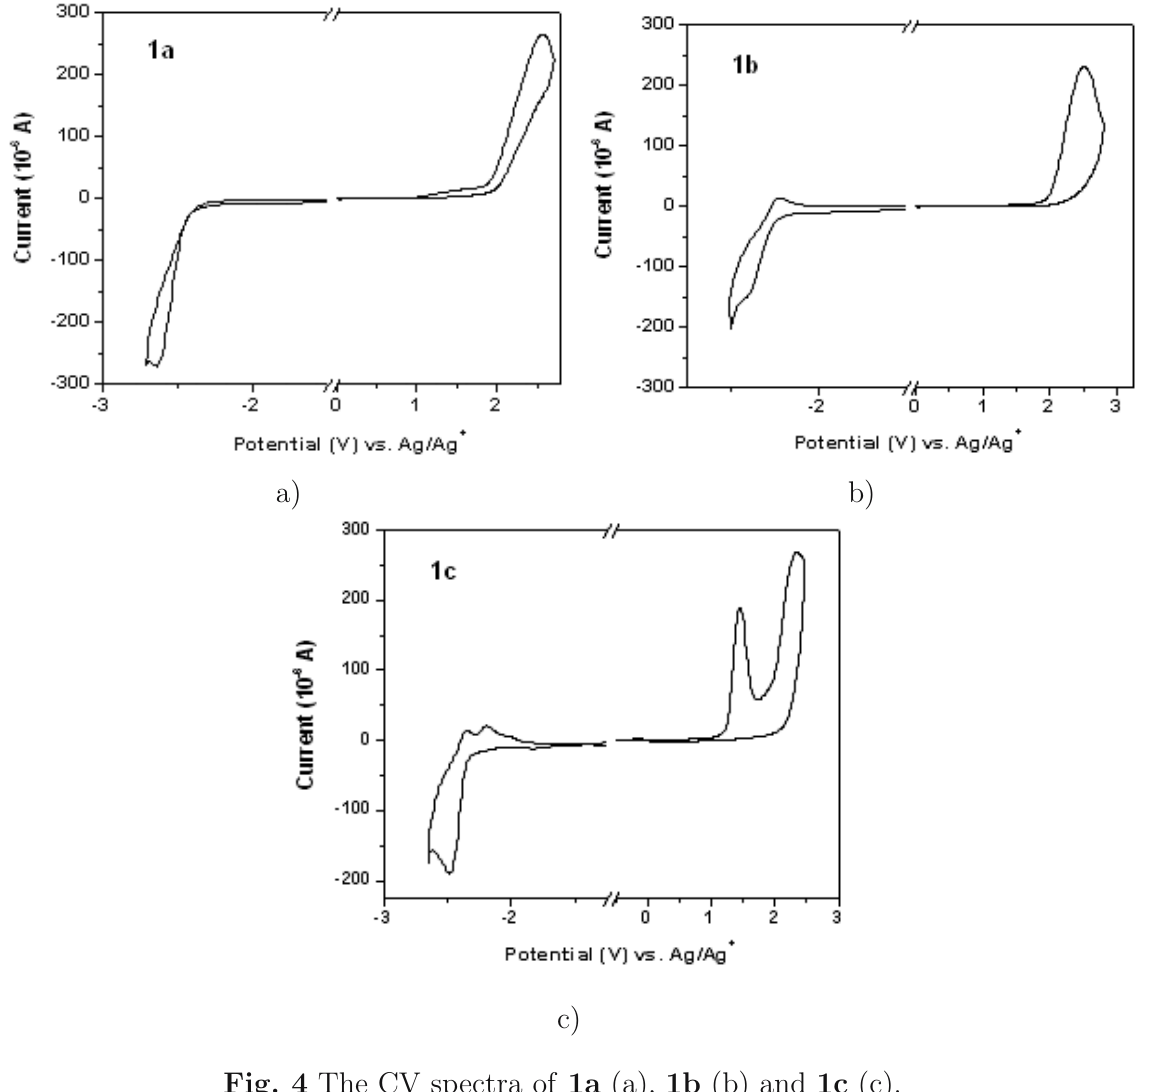
Fig. 4 The CV spectra of 1a (a), 1b (b) and 1c